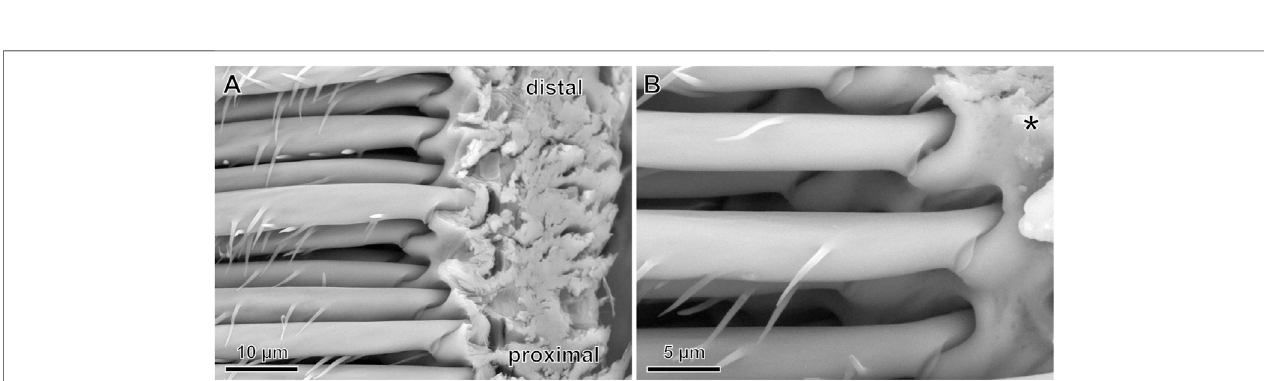
FIGURE9| SEMimagesofthebasesofpretarsaladhesivesetaeandtheirinsertionintothecuticleinaverticallydissectedexuviacuticle. (A) Ontheleftarethemost proximal parts of the adhesive setae. At their insertion in the cuticle, the hair shaftis narrowed and a stopper-like structure is situated on the ventral (lower) aspect. Distal and proximal refer to the arrangement the claw and the leg. (B) Magni fi ed cuticle insertion region of the setae. The asterisk exemplary marks the pivot point of a seta for dorsad (upward) de fl ections.